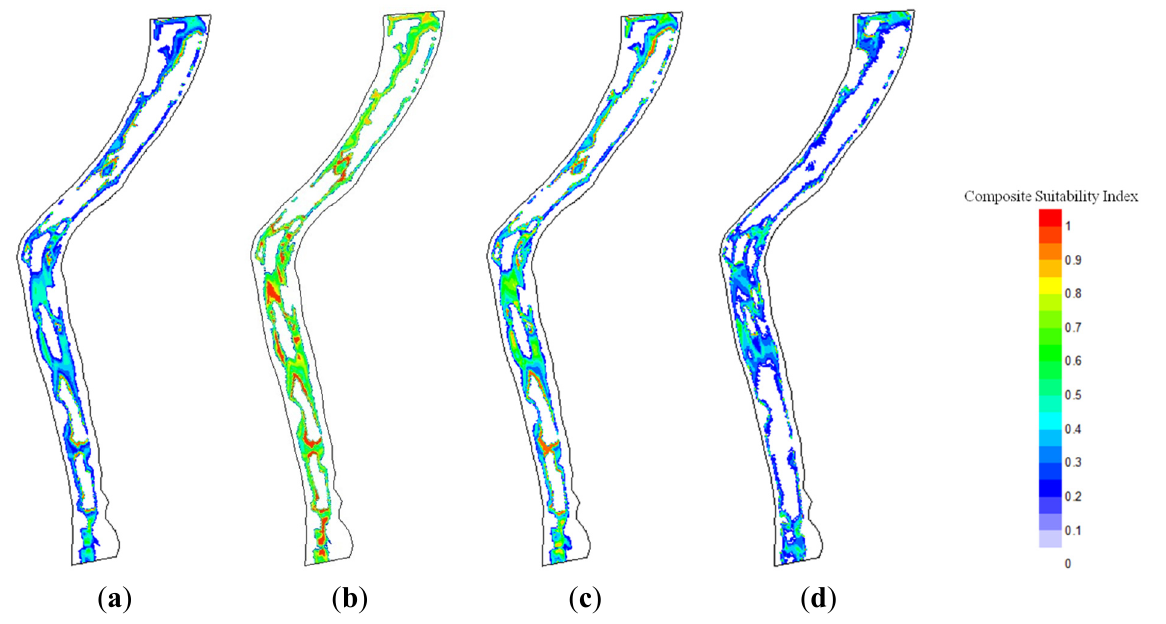
Figure 7. CSI distribution for Zacco platypus ( a ) with Dal River data; ( b ) with Hongcheon River data; ( c ) with Geum River data; ( d ) with Chogang Stream